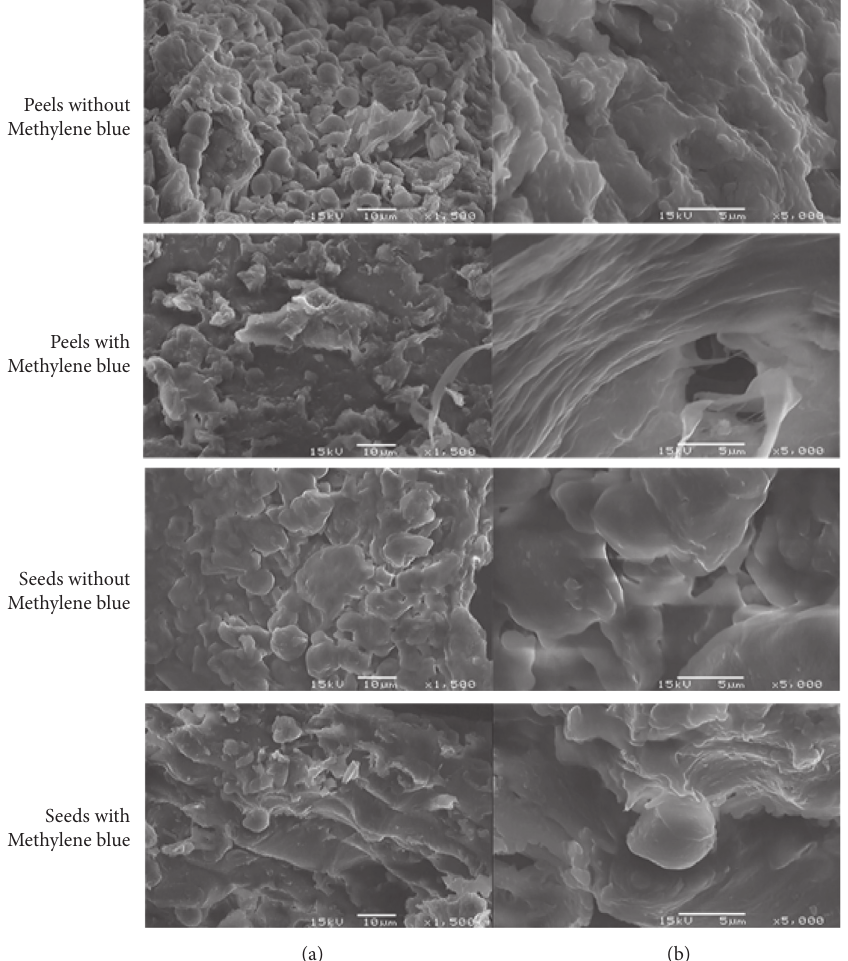
Figure 12: SEM images of the microstructure of adsorbents: peels (a) and seeds (b) before and after MB adsorption (1500x, 5000x,